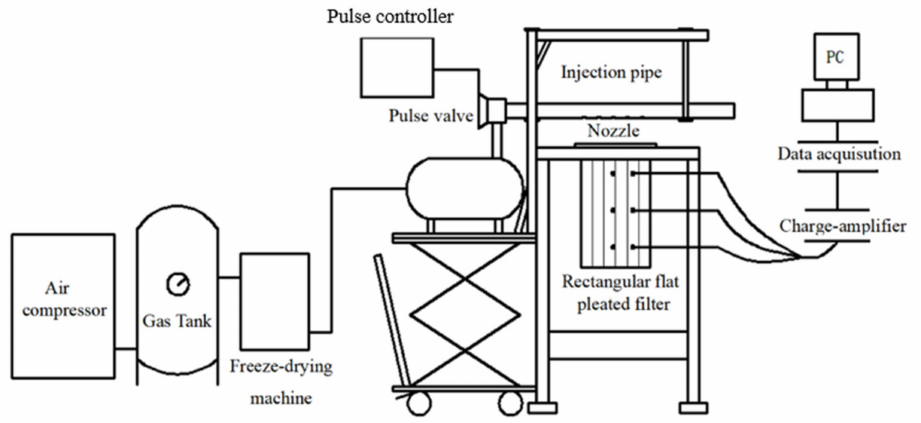
Figure 1. Pulse cleaning device used in the experiment.